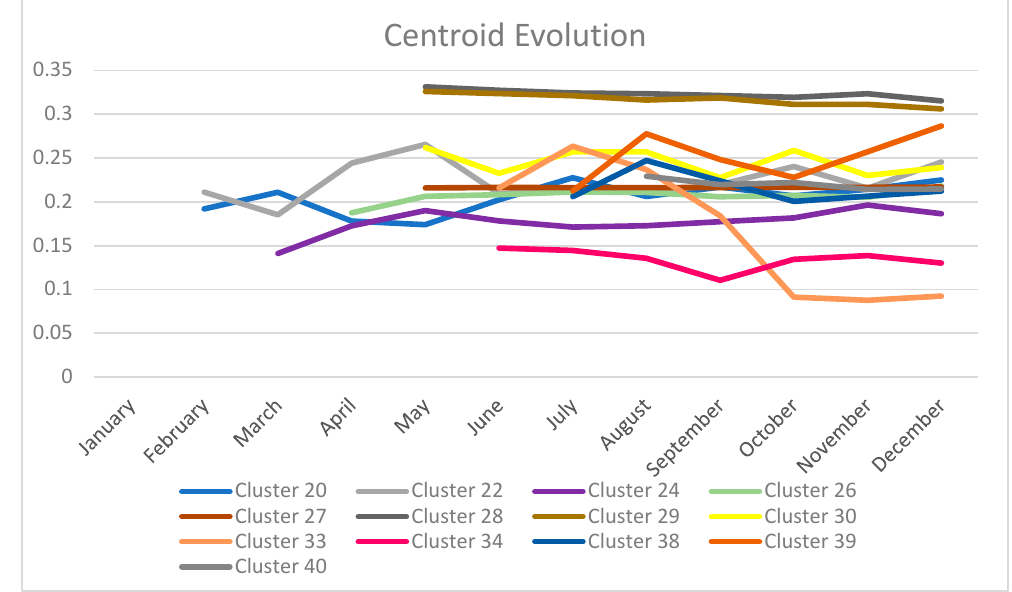
Figure 5. Evolution of the centroid of the last groups with LAMDA.